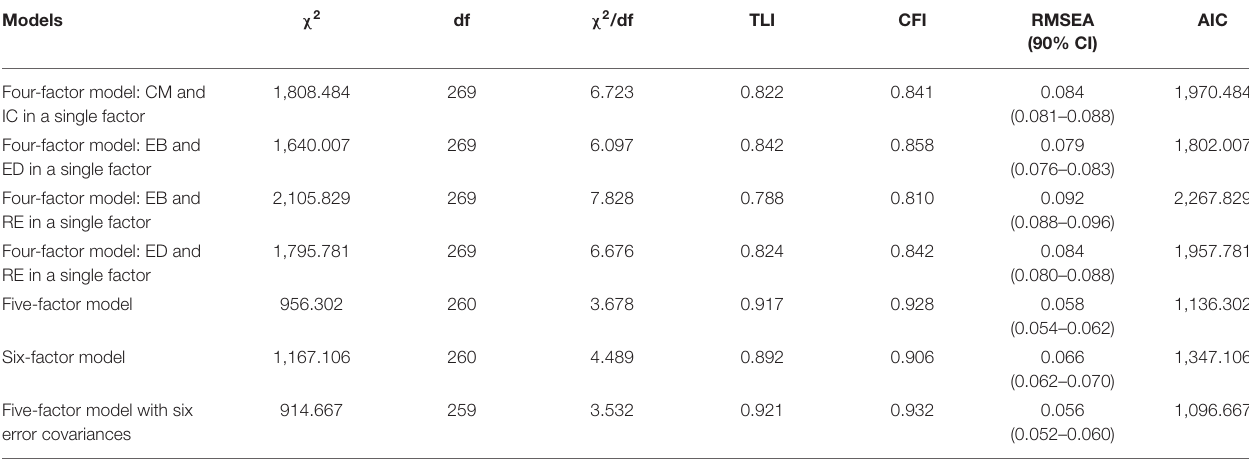
TABLE 1 | Candidate models of the structure of H-DIDS; results of CFAs. Models